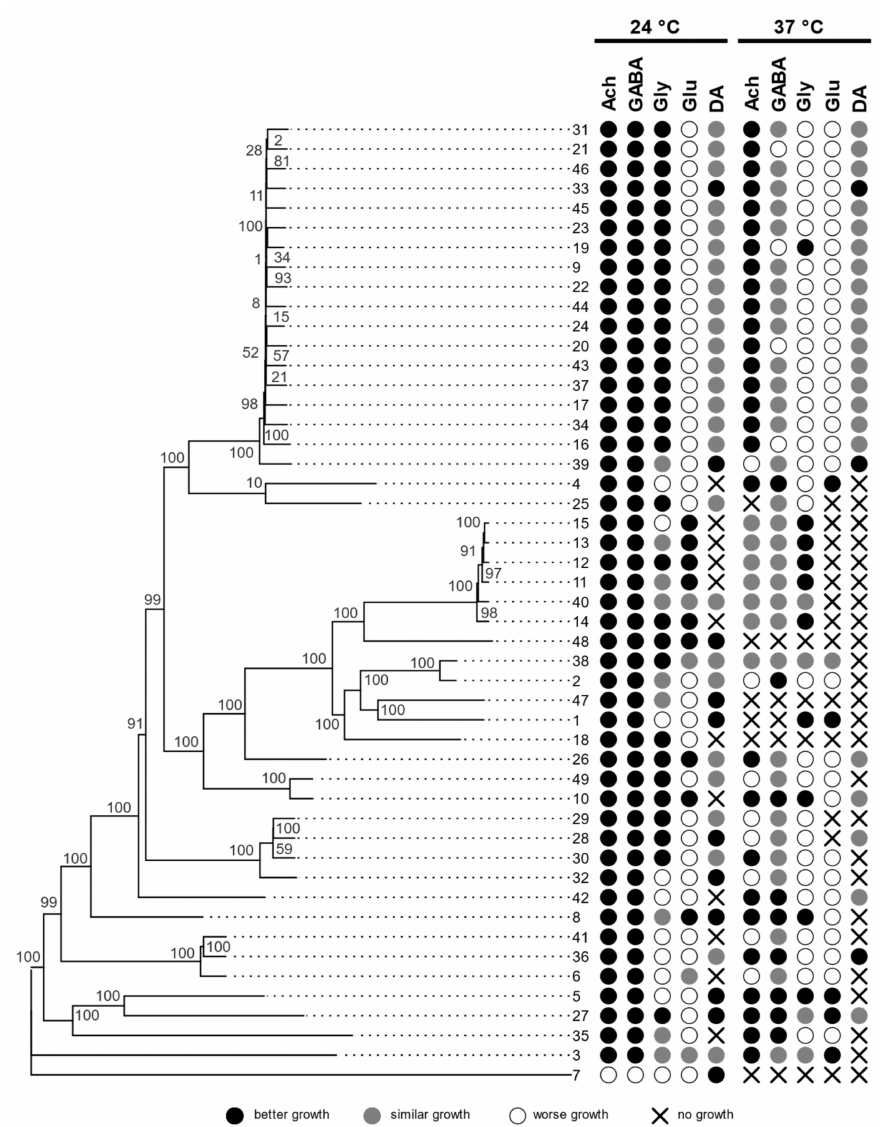
Figure 3. Phylogenomic tree of A. melanogenum strains based on whole-genome SNP data, with growth characteristics on media with different neurotransmitters, compared to the control medium with no added neurotransmitters. Assimilation of hydrocarbons is shown in the circles (acetylcholine—ACh, γ -aminobutyric acid—GABA, glycine—Gly, glutamate—Glu,